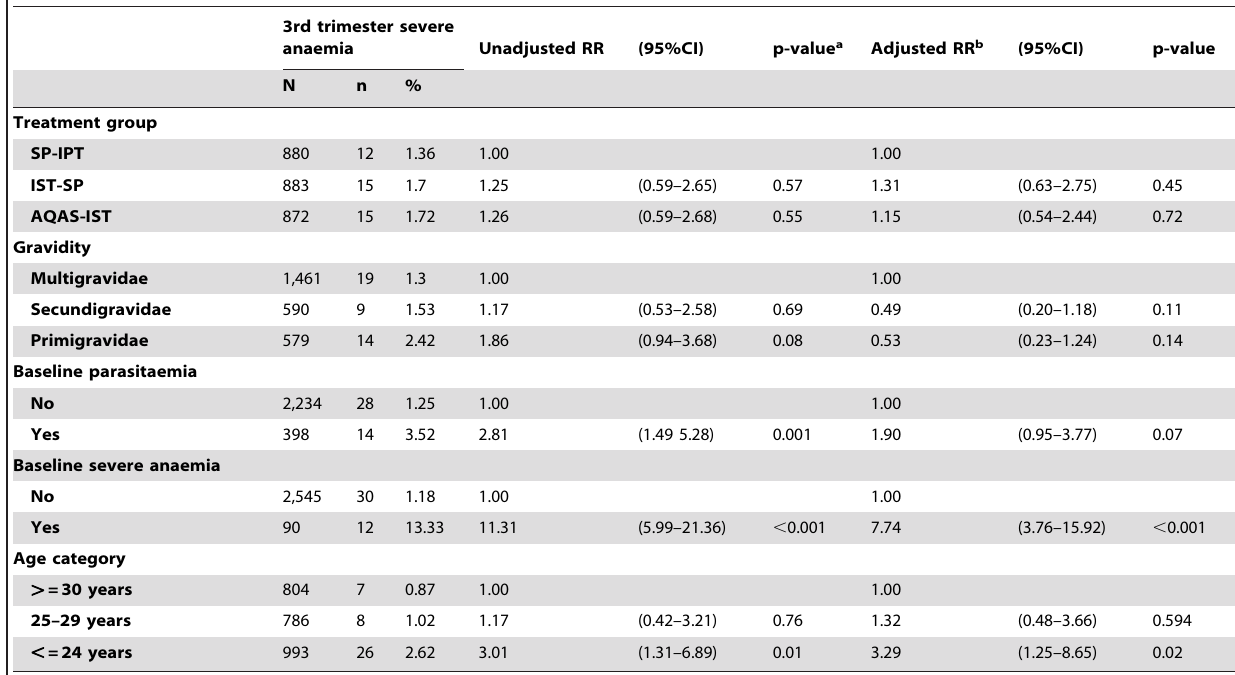
Table 3. Factors associated with third trimester severe anaemia in study